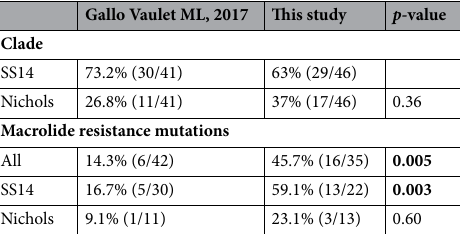
Gallo Vaulet ML, 2017 This study p